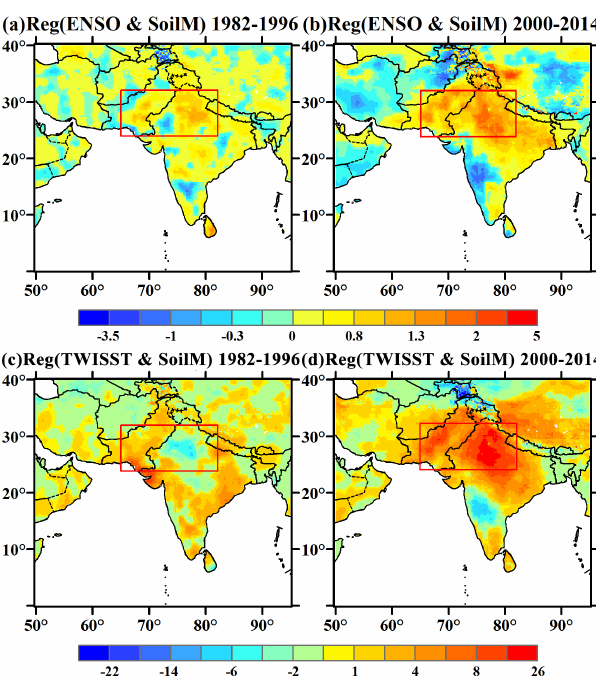
Figure 12. (a–b) Regression of ENSO with TWISST-related sig- nals removed onto PPT in the dust season (June–July). (c–d) Re- gression of TWISST with ENSO-related signals removed onto PPT in the dust season (June–July).